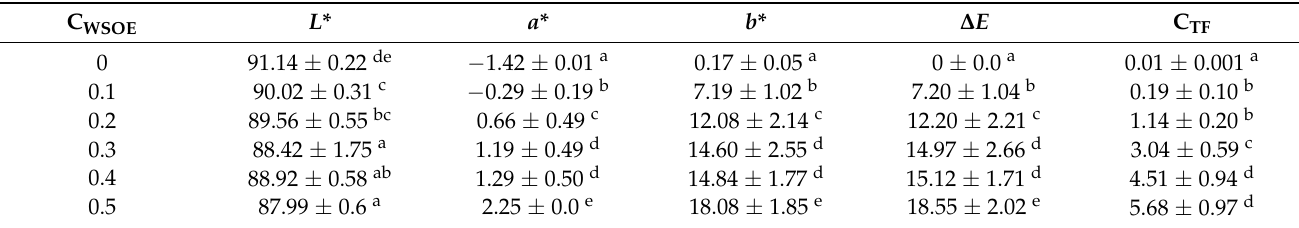
Table 5. Effect on the luminosity ( L* ), chroma a* , chroma b* , total color difference, and total phenolic concentration (C TF , mg of gallic acid equivalents/100 g of film) of cross-linked cassava starch- based films with different concentrations of watermelon seed oil emulsions (C WSOE , g/100 g of film-forming